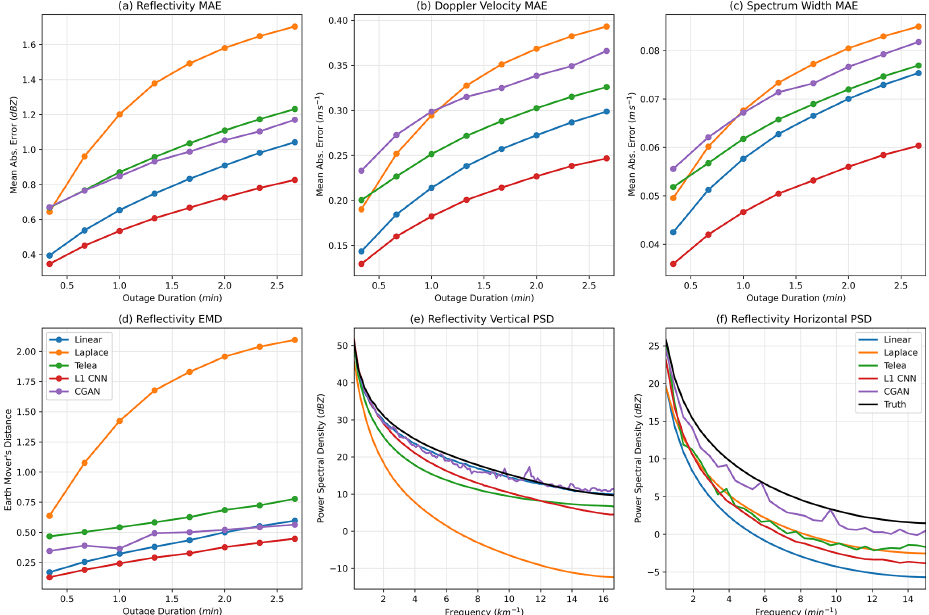
Figure 4. Error metrics computed on the KaZR outage inpainting scenario. Panels (a) – (c) show mean absolute pixel errors. Panel (d) shows the earth mover’s distance. Panels (e) and (f) show power spectral